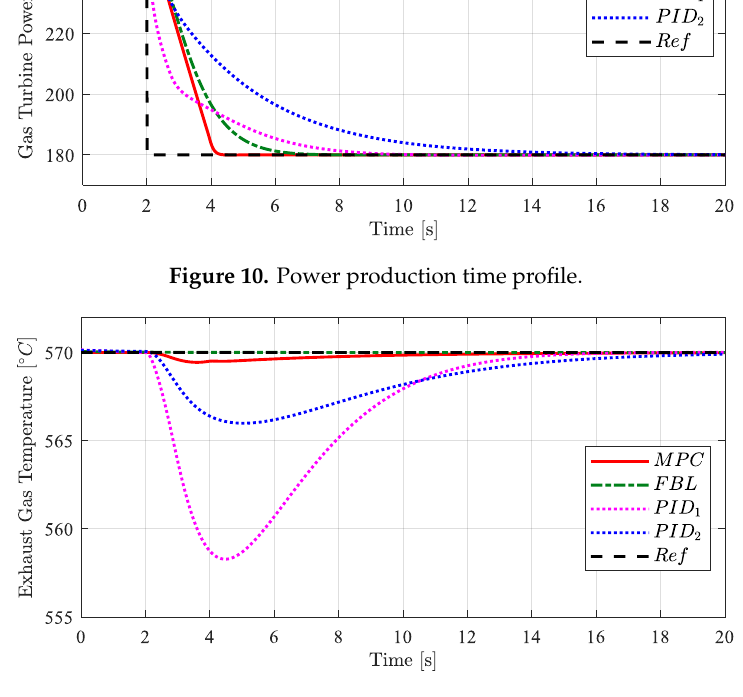
Figure 11. EGT time profile.